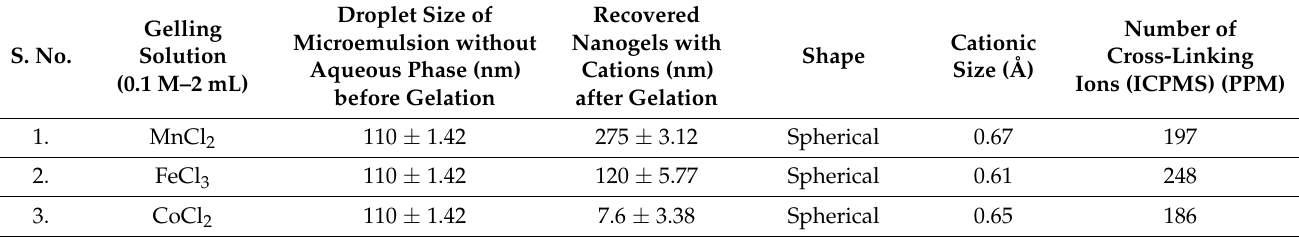
Figure 3. W/O microemulsion of Span 20, representing points ( A` ) (clear microemulsion), ( B` ) (slightly turbid microemulsion) and ( C` ) (milky appearance microemulsion). turbid microemulsion) and ( C’ ) (milky appearance microemulsion). Table 1. DLS data obtained from microemulsion with different divalent cation solutions collected before, and 1 h after, the addition of divalent cation